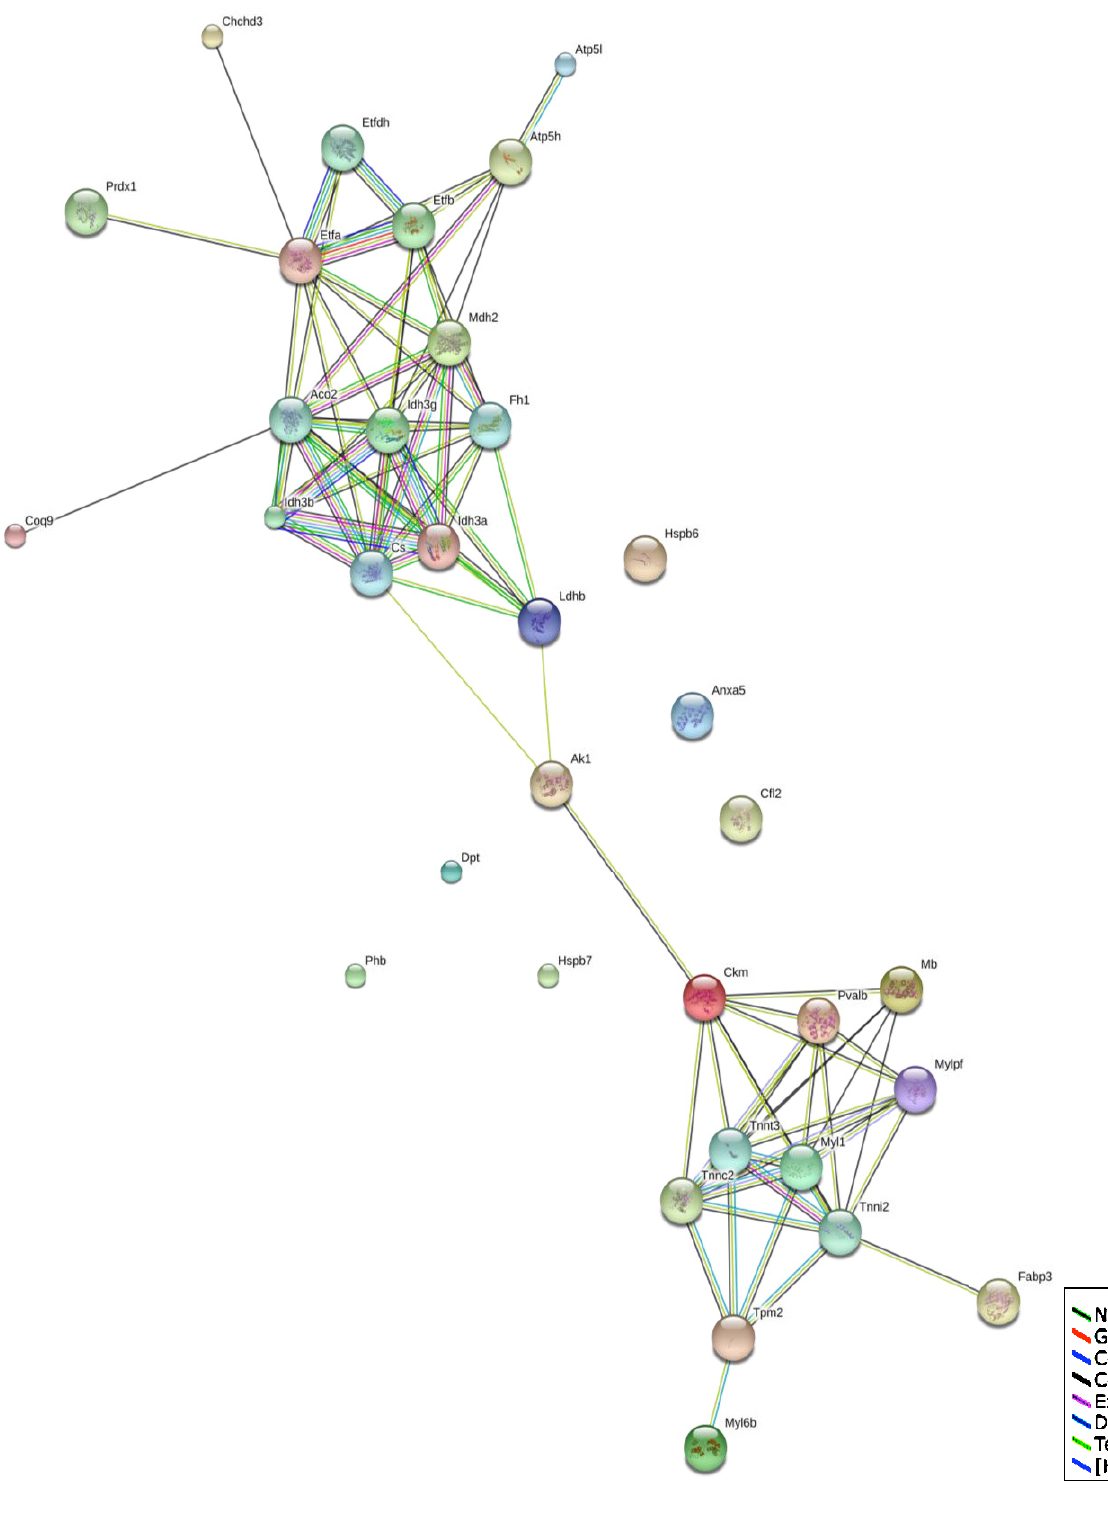
Figure 6. Interaction map of altered mdx diaphragm-associated proteins: The bioinformatics STRING database (version 9.1; [66,67]) was used to generate a protein interaction map with known and predicted protein associations that include direct physical and indirect functional protein linkages of the mass spectrometrically identified proteins with a changed abundance in aged mdx diaphragm as compared to normal muscle (Table